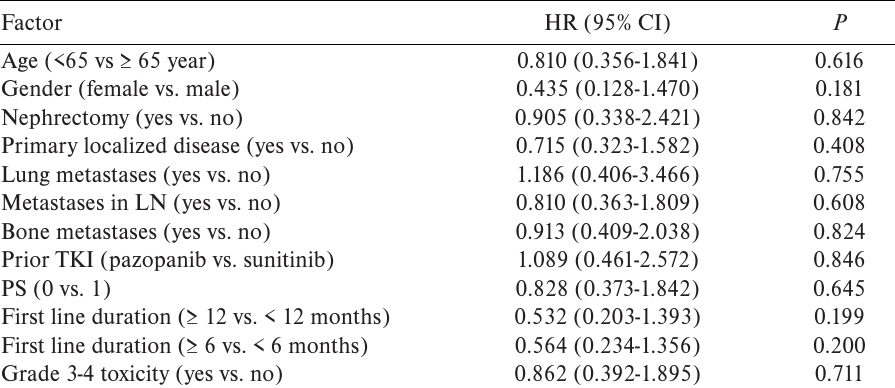
Table 2. Factor impact on progression-free survival.